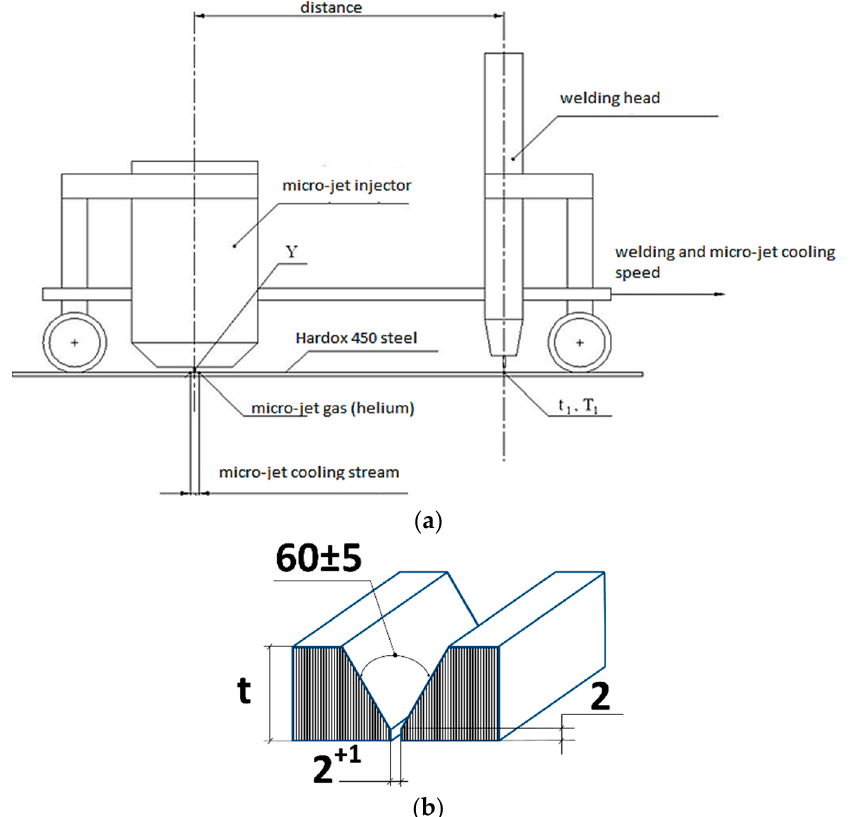
Figure 1. Scheme of the welding process with micro-jet cooling and ( a ) the groove shape and beveling method from the Hardox 450 steel with a thickness t = 6 mm ( b ).